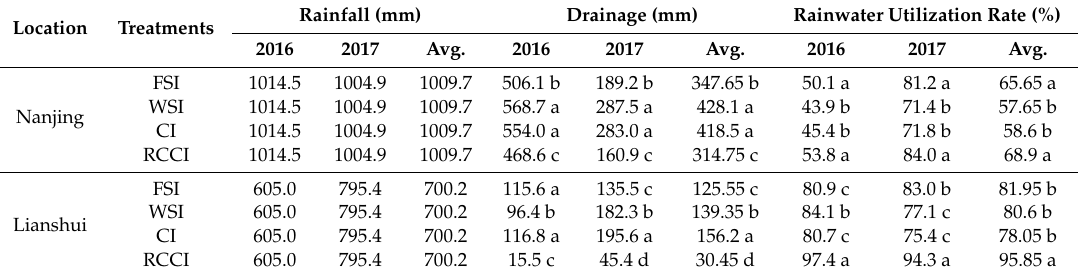
Table 2. E ff ect of di ff erent irrigation methods on drainage and rainwater utilization rate.